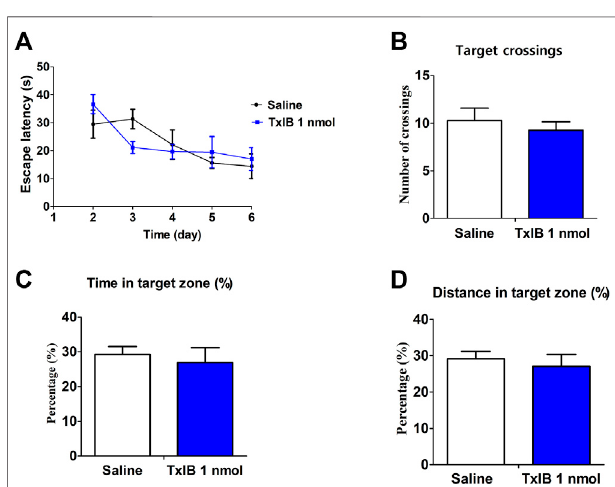
FIGURE 7 | Direct effects of α -conotoxin TxIB in Morris water maze test. Data are presented as the mean ± SEM, n (cid:1) 7. (A) The escape latency from water onto the platform during the hidden platform test. Spatial memory was assessed in a probe trial with respect to: (B) target crossings, (C) percent of time in target quadrant, (D) percent of distance in target quadrant. Compared with the saline group, there was no signi fi cance.